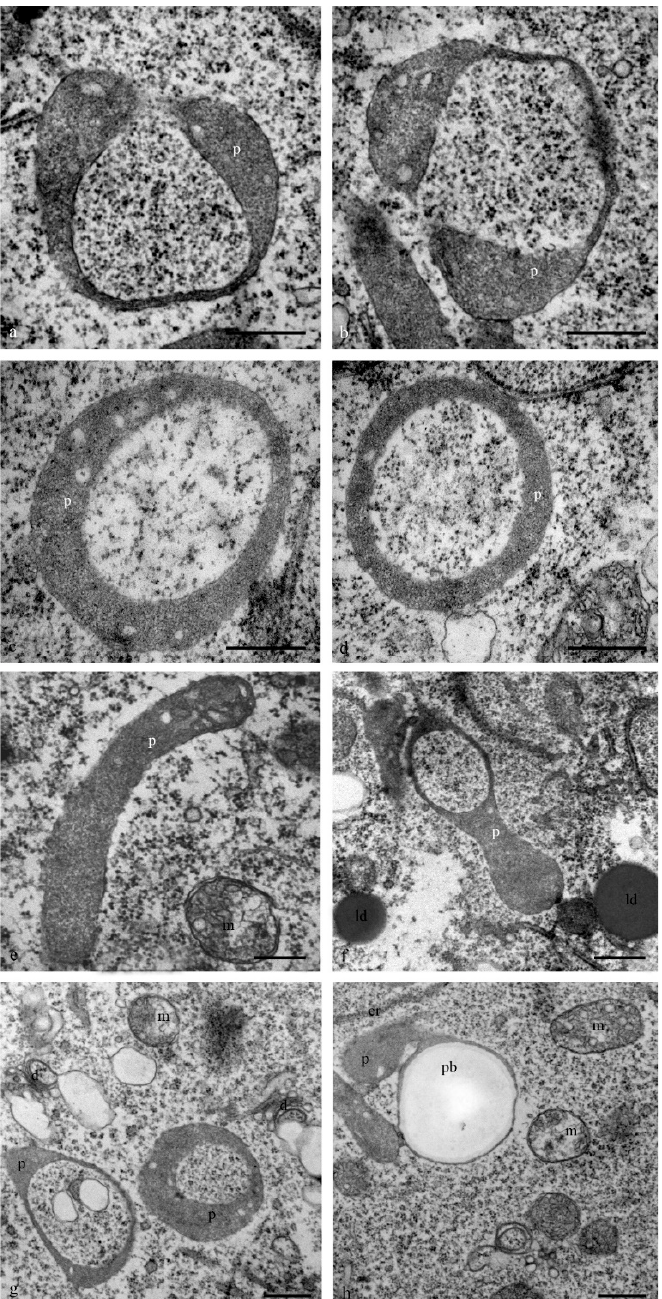
Figure 10. Ultrastructure of the plastids (leukoplasts) of the cytoplasm of the antipodal cells. At stages of active cell functioning, the shape and size of the plastids vary. A granular stroma, and single lamellae and several small starch grains ( a – g ) are evident. Plastids can have constrictions ( a , b ), a cup shape ( c , d , g ), a stick shape, a cup-shaped area ( e , f ), or a complex shape ( h ). p—plastids; m—mitochondria; d—dictyosomes; pb—protein body; ld—lipid droplets. The scale is 500 nm. The structure of the cell walls between the antipodal cells was heterogeneous. The thickness changed, and the cell wall contained disordered hemicellulose microfibrils. Ex- ocytosis or endocytosis of multivesicular bodies within the cell walls or apoplast was frequently observed (Figure 11). The transfer of organelles including plastids and mito- chondria through wide channels was observed in the cell wall between the cells (Figure 11e) and between the antipodal cells and coenocyte of the endosperm.